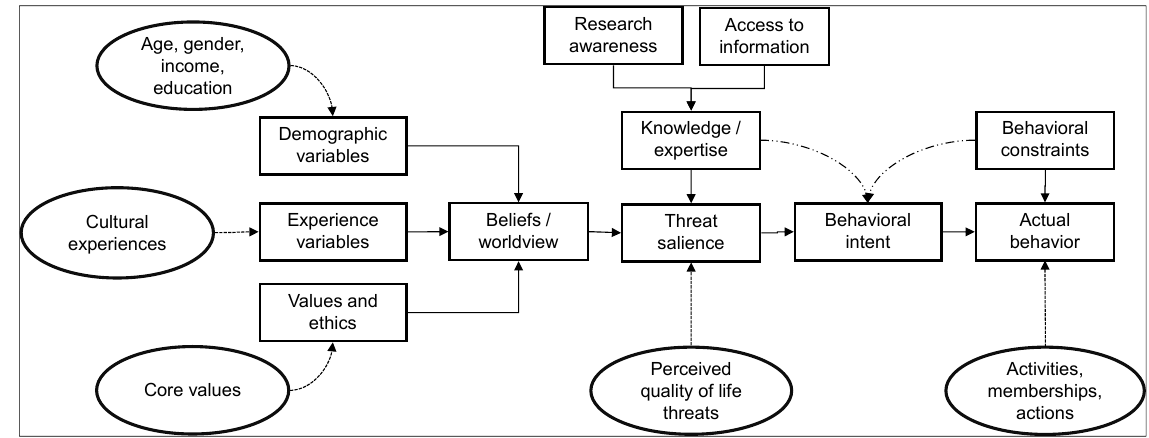
Figure 1. Causal linkages between threat perceptions and their precursors, and intended and realized behavior in a modified value-belief-norm theoretical